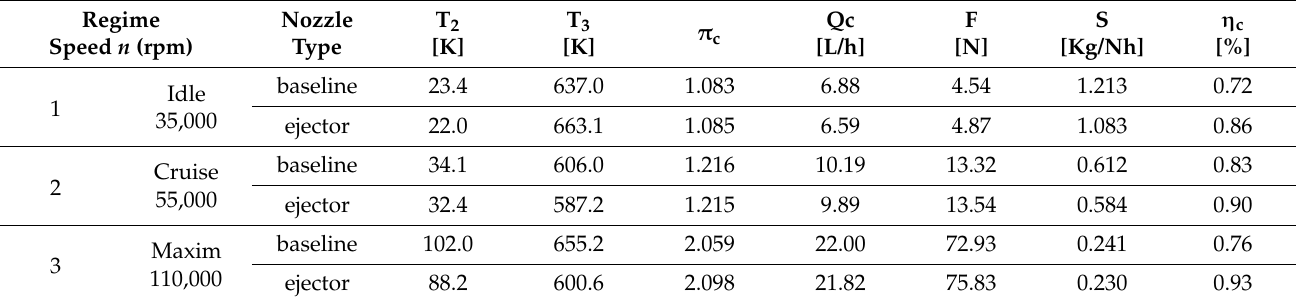
Table 1. Turbojet engine operating